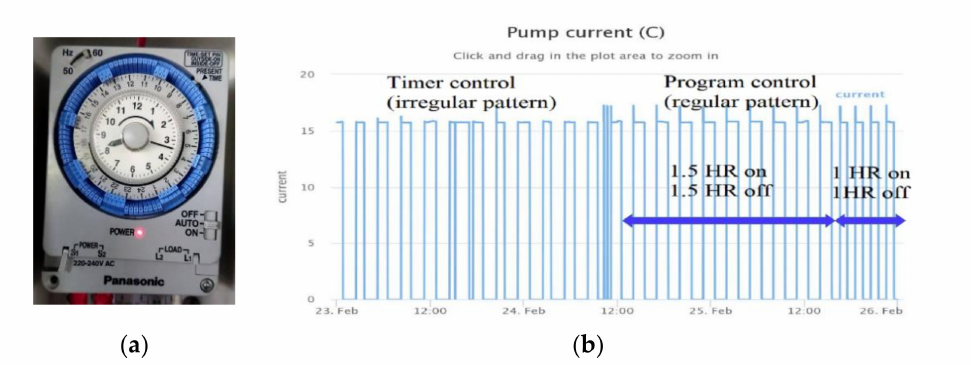
Figure 12. A photo of timer ( a ) and a snapshot of current drawn by the pump ( b